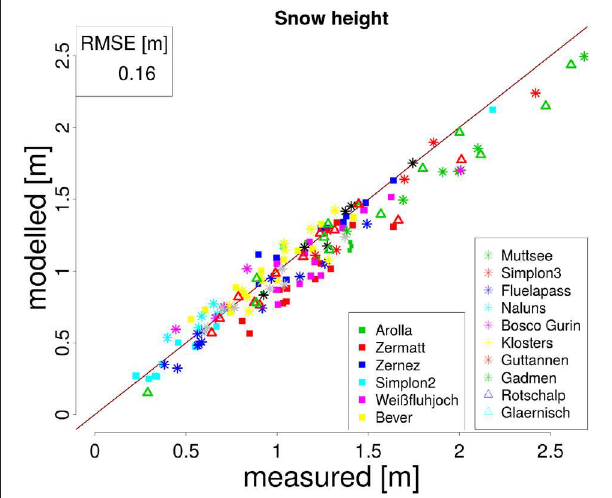
FIGURE 2 | Scattered plot of modeled and measured maximum annual snow height for station used in the study. Dots represent the stations. Squares represent high alpine stations, stars alpine stations, and triangles low alpine. The root mean square error (RMSE) for all stations is 0.16